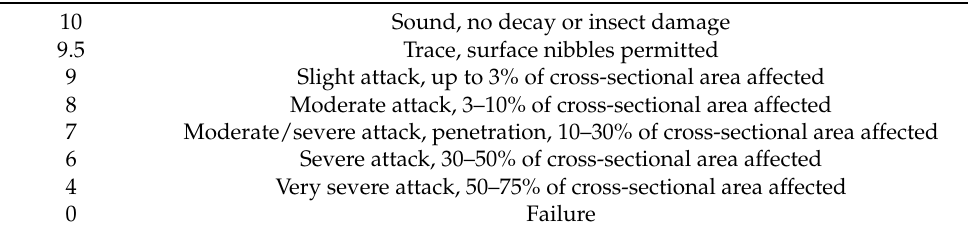
Table 2. AWPA E7 and E26 visual termite and decay damage rating